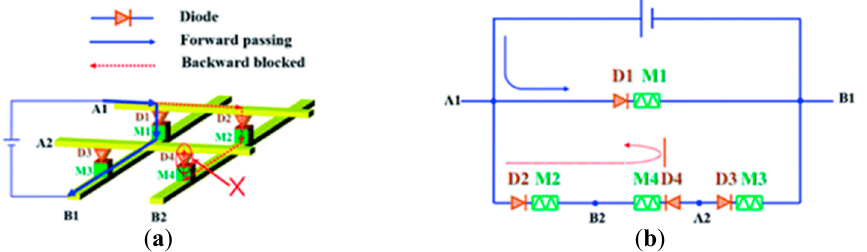
Figure 18. Memristors structure and equivalent circuit with 1D1M solution ( a ) A structure diagram of a one diode–one memristor (1D1M) model and ( b ) the equivalent circuit 1D1M solution.